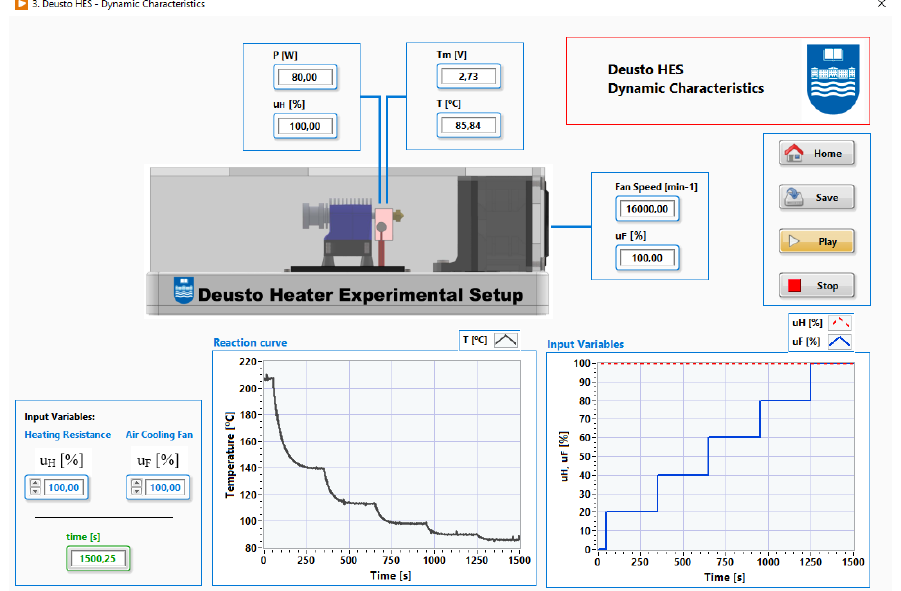
Figure 18. LabVIEW-based application for obtaining dynamic characteristics for different configu- rations of the controlled process and different operating points.